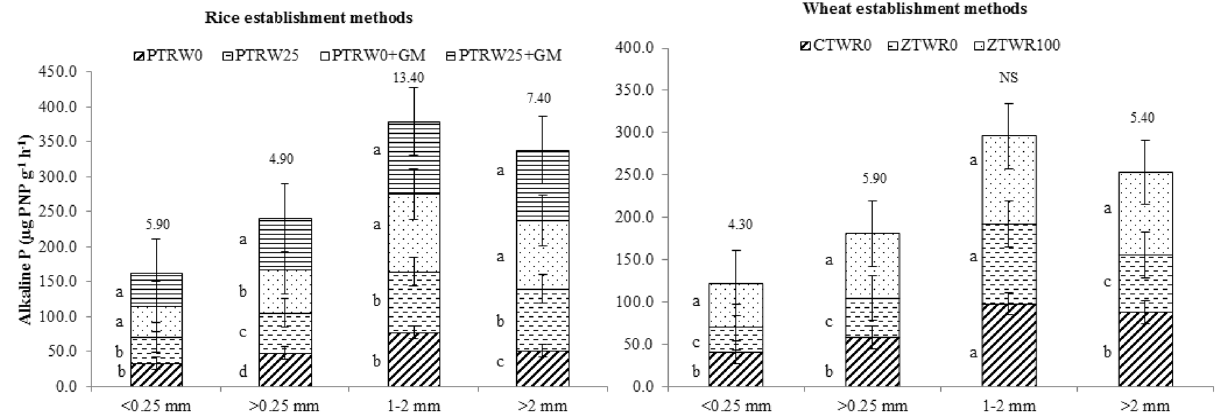
Figure 5. Effect of tillage, green manure and residue management practices on alkaline phosphatase within aggregates after five years of rice–wheat cropping system. PTR W0 -puddled transplanted rice with no wheat straw, PTR W25 -puddled transplanted rice with 25% anchored wheat straw retained, GM-Green manure, CTW R0 -conventional tillage wheat with rice straw removed, ZTW R0 -zero tillage wheat with rice straw removed, ZTW R100 -ZTW with rice straw retained as surface mulch. Vertical bars are the standard errors of the mean ( p < 0.05 ). The values above the vertical bars represent least significant difference test.